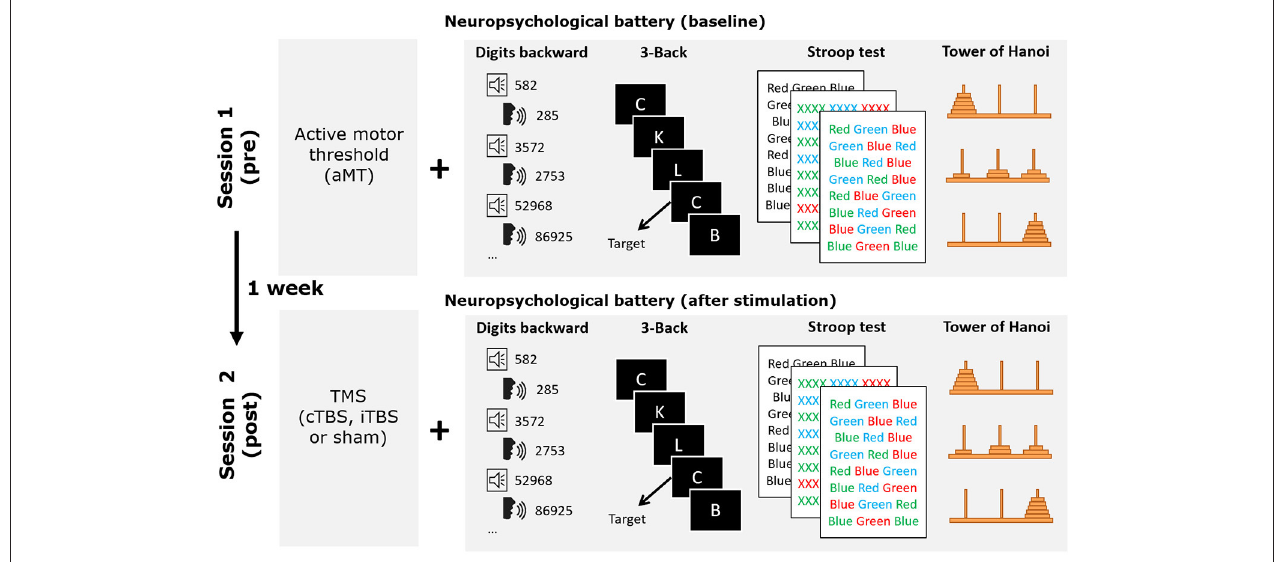
FIGURE 1 | Schematic drawing representing the details of the experimental procedure followed by participants. During session 1 active motor threshold was determined before performing the neuropsychological battery of tests used in the study. One week thereafter, during session 2, the neuropsychological battery was performed again following one of the three TBS stimulation conditions (iTBS, cTBS or sham). Behavioral tasks were always administered in the same